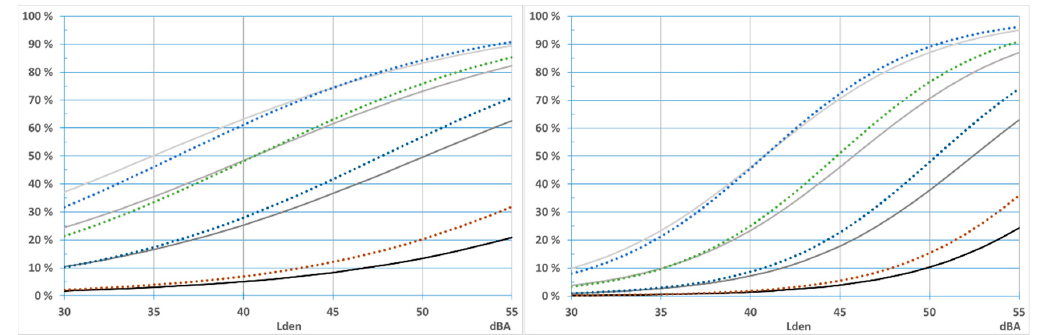
Figure 9. Exposure–effect relationships for annoyance right outside dwelling ( left panel ), and when indoors ( right panel ). Curves before (dotted lines) and after correction for noise sensitivity. n = 87.